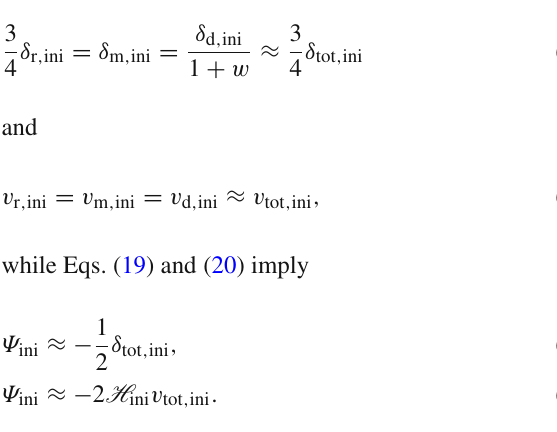
Fig. 2 The evolution of the Fourier mode of the gravitational poten- tial Φ k (top panel), the DM perturbation δ m (middle panels) and the DE perturbation (bottom panel), from the matter era to the far future for the mode k = 10 − 3 Mpc − 1 and for three dark energy models: (blue) w = − 0 . 99, (green) w = − 1 and (red) w = − 1 . 01. For the quintessence model (blue) the gravitational potential evolves towards a constant in the far future without changing sign, while for Λ CDM (green) Φ k vanishes asymptotically. In the phantom model (red), Φ k also evolves towards a constant in the far future but a change of sign occurs roughly at log 10 a / a 0 (cid:8) 2 . 33, corresponding to 8 . 84 × 10 10 years in the future. A dashed line indicates negative values of Φ